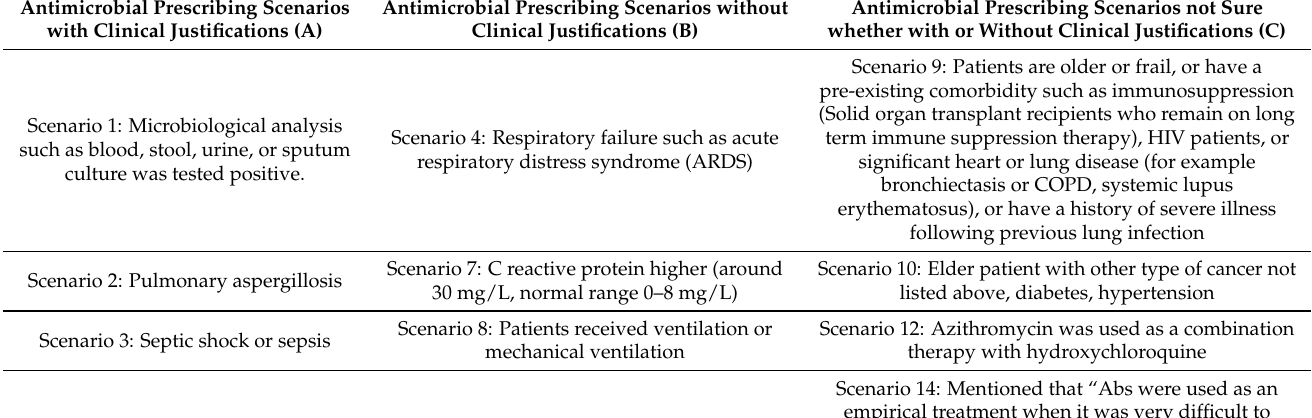
Table 3. Antimicrobial prescribing scenarios of hospitalized COVID-19 patients. Antimicrobial Prescribing Scenarios Antimicrobial Prescribing Scenarios without with Clinical Justifications (A) Clinical Justifications